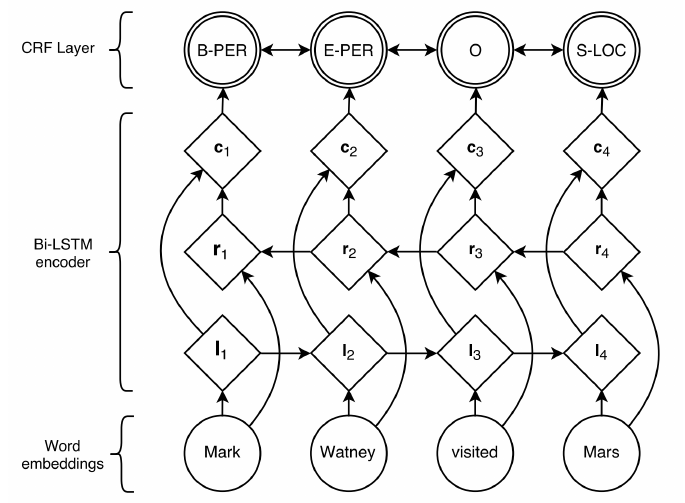
Figure 7. Bidirectional Long Short Term Memory Conditional Random